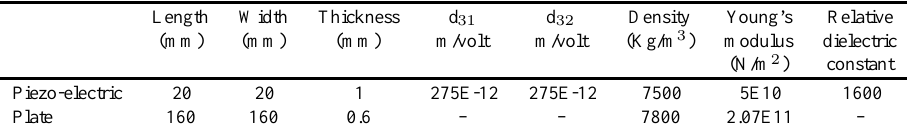
Table 2 Physical and geometrical specifications of the plate and piezoelectric